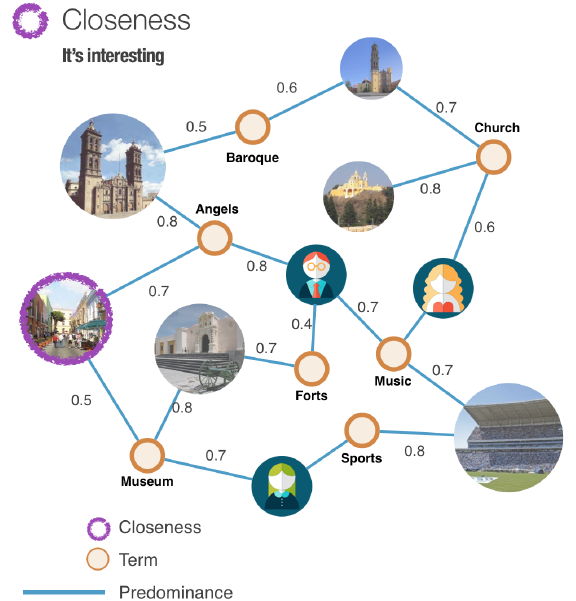
Figure 5: “Could be interesting” as a result of computing close-